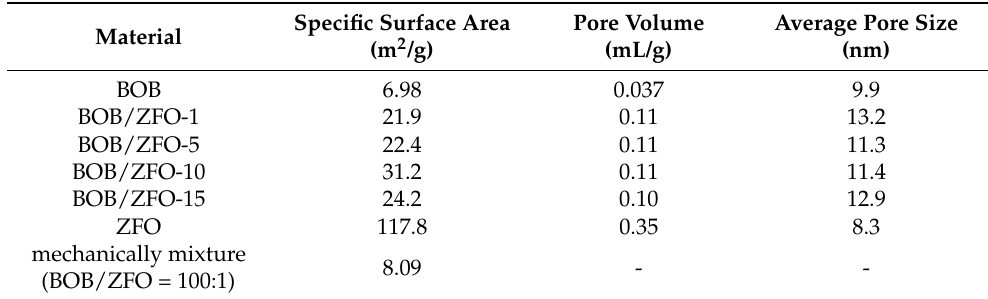
Table 1. Specific surface area, pore volume and average pore size of BOB, ZFO and BOB/ZFO-x